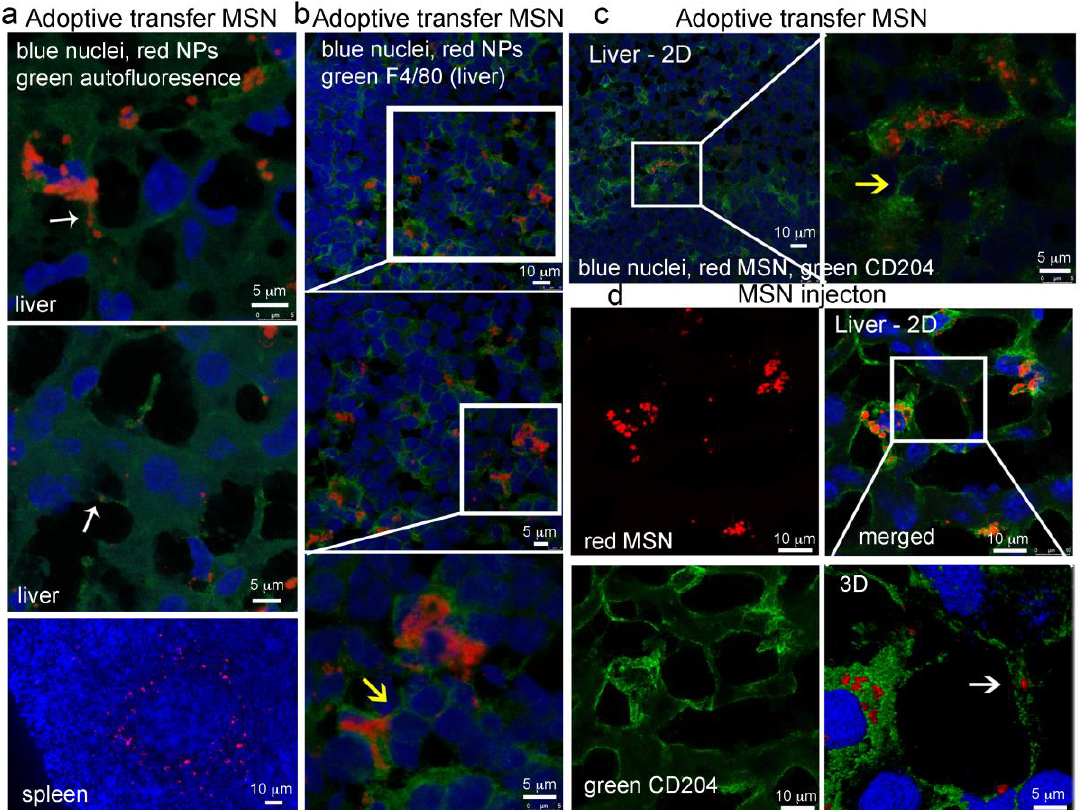
Figure 8. Association of MSN with macrophages in immune-competent syngeneic mice following intravenous injection. BALB/C mice with 4T1 breast tumors were injected intravenously with 250 µg DyLight 633-labeled MSN (red) directly (d, free) or via the adoptive transfer of splenocytes preloaded with MSN ( a – c ). Twenty-four-hour post-administration, filtering organs and tumors were excised and labeled with either F4/80 or CD204 fluorescent antibodies (green). ( a ) Liver and spleen with no antibody staining (green, autofluorescence). ( b ) F4/80-labeled (green) tissues. ( c , d ) CD204-labeled (green) tissues. Arrows highlight cell-to-cell connections with (white) or without (yellow) MSN.